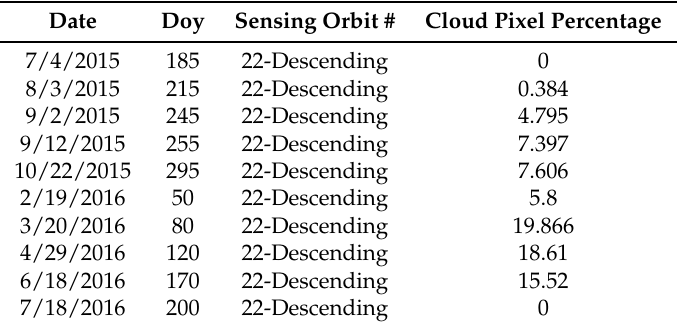
Table 2. Sentinel-2 data